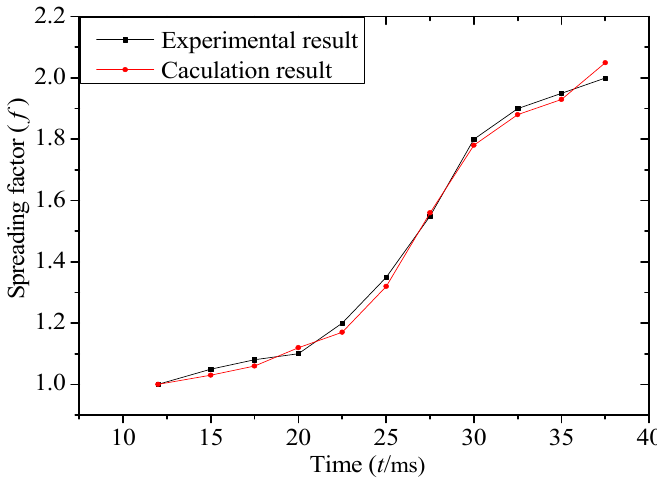
Figure 8. Drop spreading coefficient varying with time t .